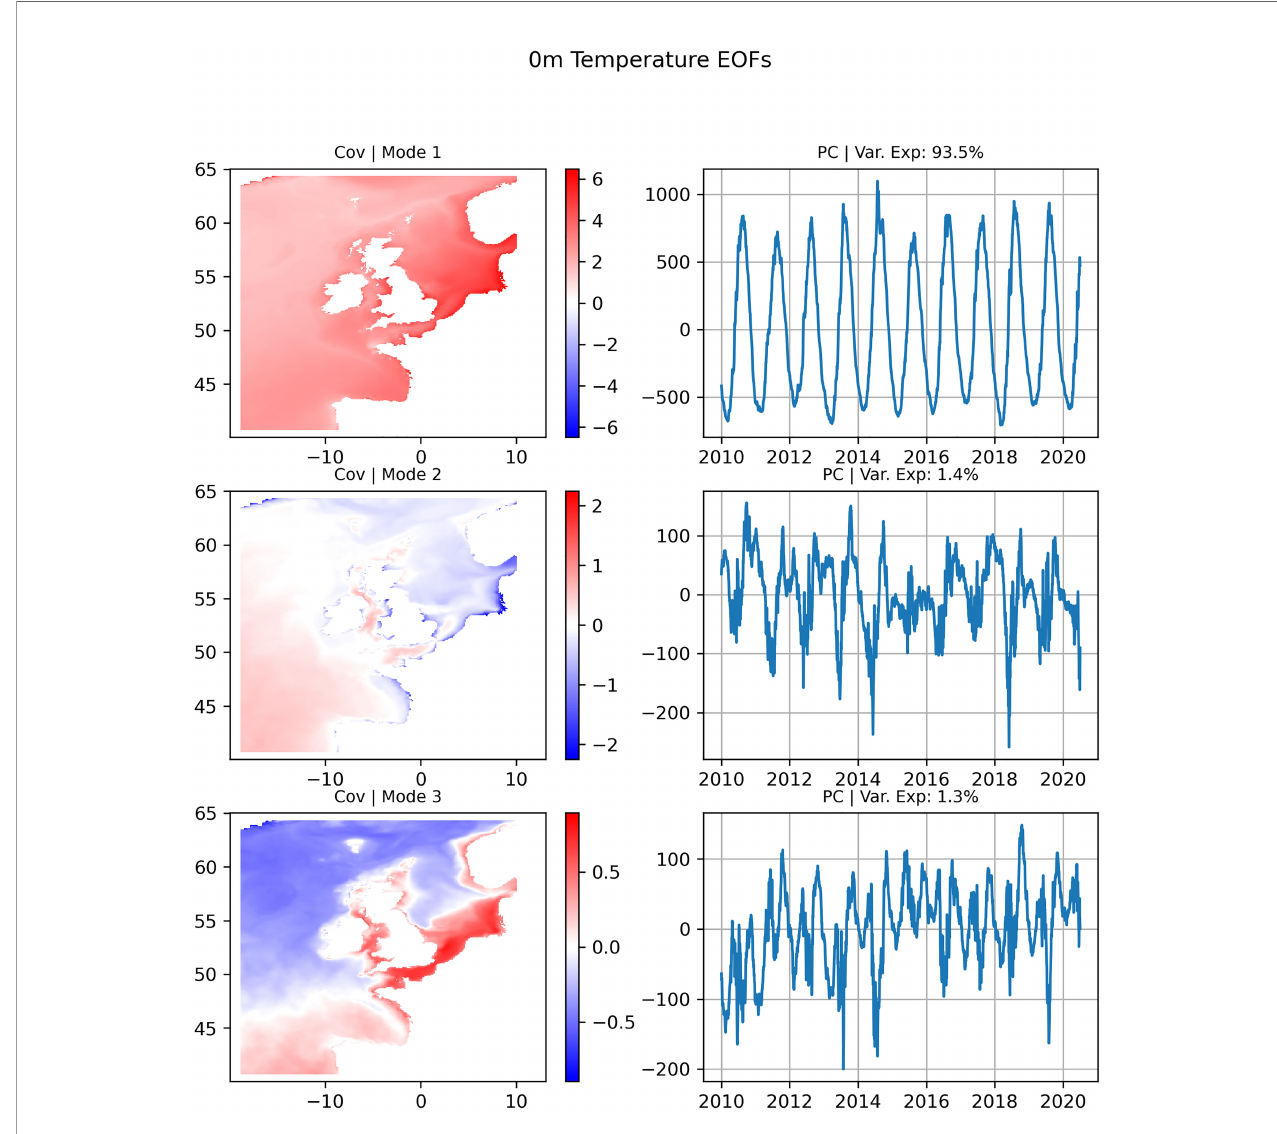
FIGURE 9 | The 3 largest modes (top to bottom) of an EOF analysis of Sea Surface Temperature (SST). The largest mode dominates the SST signal, explaining 93.5% of the signal